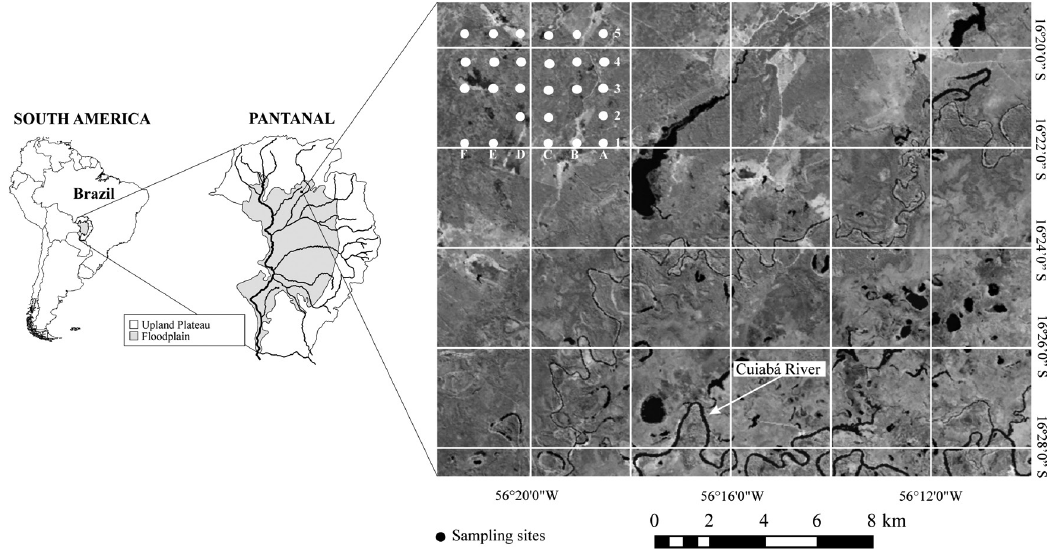
Figure 1. Location of the study area and of the Long-Term Sampling Site (LTSS) in a seasonally flooded area of the northern Pantanal,